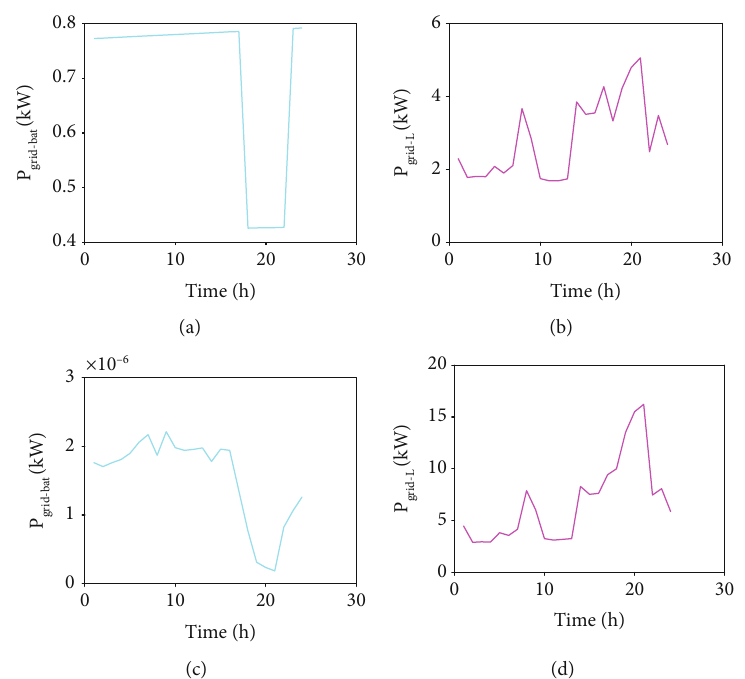
Figure 14: (a, b) Import of grid power in strategy (1); c, d: import of grid power in strategy